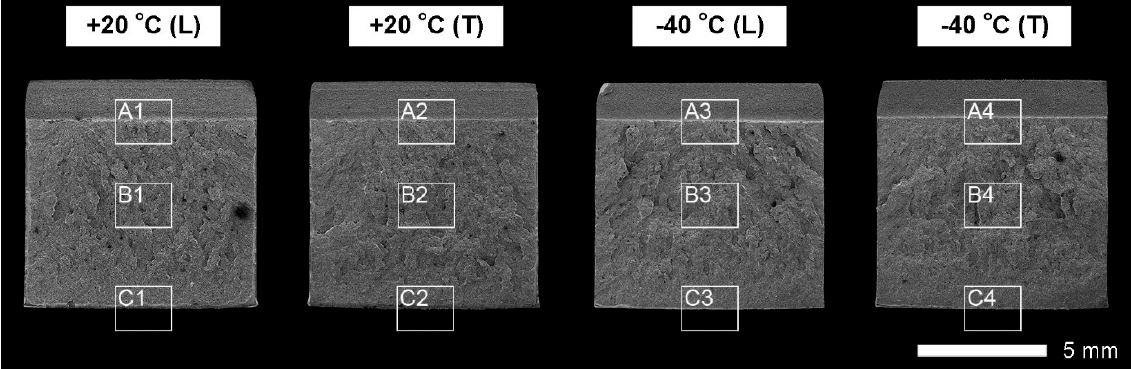
Figure 10. Macroscopic image of fractures in representative specimens of Hardox Extreme steel in a normalized state: L—longitudinal orientation, T—transverse orientation; frames are used to mark: A—zone below the notch, B—central zone, C—final-fracture zone. SEM, non-etched state.